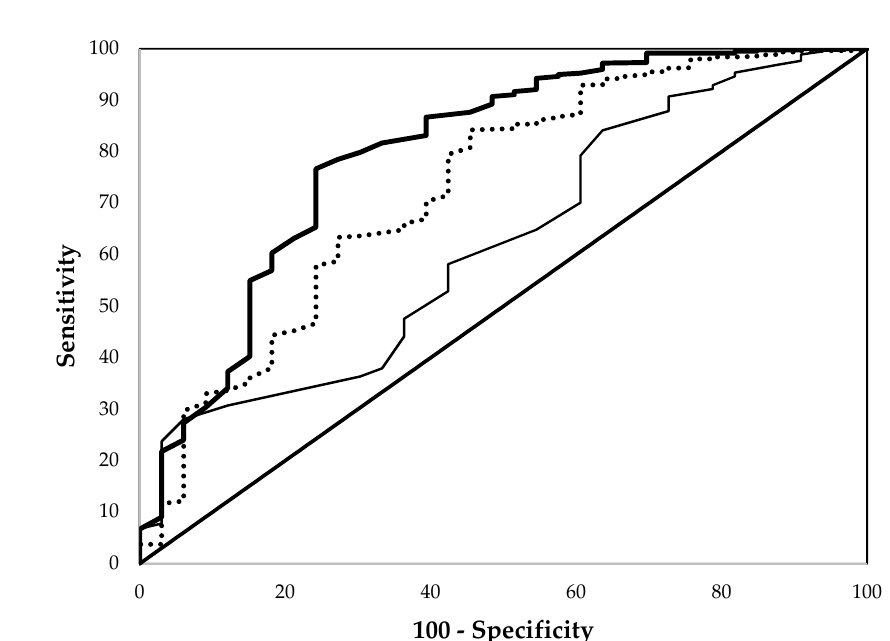
Figure 1. Comparison of the receiver operating characteristic curves of erythrocyte protoporphyrin (thick line), hemoglobin (thin line), and mean cell volume (dashed line) in detecting iron deficiency for children aged three to five years from the National Health and Nutrition Examination Surveys 2003–2006.